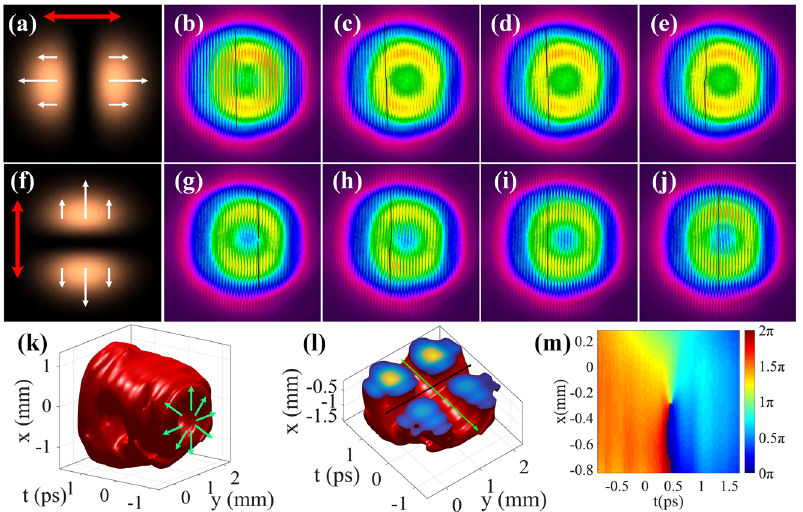
Figure 3: Experimental results for characterizing radially polarized STOV. (a) Diagramof the pattern for the horizontally polarized component withina radially polarized object beam. (b – e) The interference patterns at several representative temporal locations of the object wavepacket when the probe beam is horizontally polarized. (f) Diagram of the pattern for the vertically polarized component within a radially polarized object beam. (g – j) The interference patterns at several representative temporal locations of the object wavepacket when the probe beam is vertically polarized. The reconstructed 3D spatiotemporal wavepacket (k) and its cut-through view (l). (m) The experimentally reconstructed spatiotemporal phase distribution. The red arrows in (a) and (f) indicate the polarization direction of the probe beam, and the white arrows indicate the polarization direction of corresponding components within object beam. The black lines in (b) – (e) and (g) – (j) indicate the relative location between the upper and lower fringes in each interference pattern. The green arrows in (k) represent the radial polarization of the STOV. The green and black lines in (l) indicate the traces of the polarization and OAM singularities,